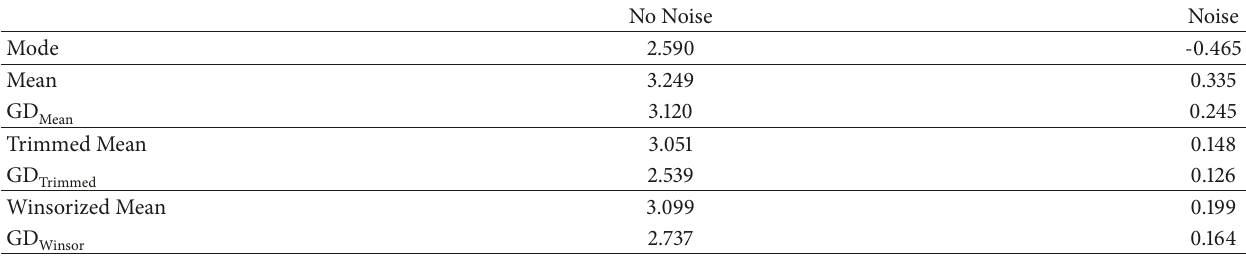
Table 79: Log-normal distributions with step noise (Type 3). The uniform noise is applied in the range from the minus maximum value to the minimum value of the distribution. The frequency of the samples decreases linearly, going to create a noise-shaped step. The noise is composed of 1000 points.